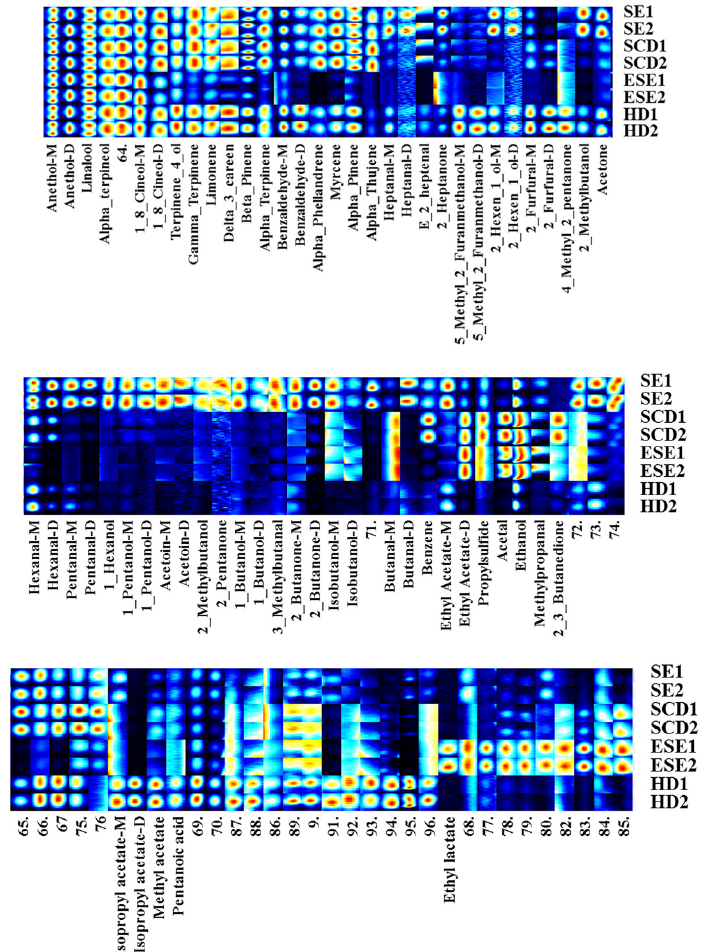
Figure 5. Corridor diagram of volatile compounds of SAEOs extracted by four different methods.